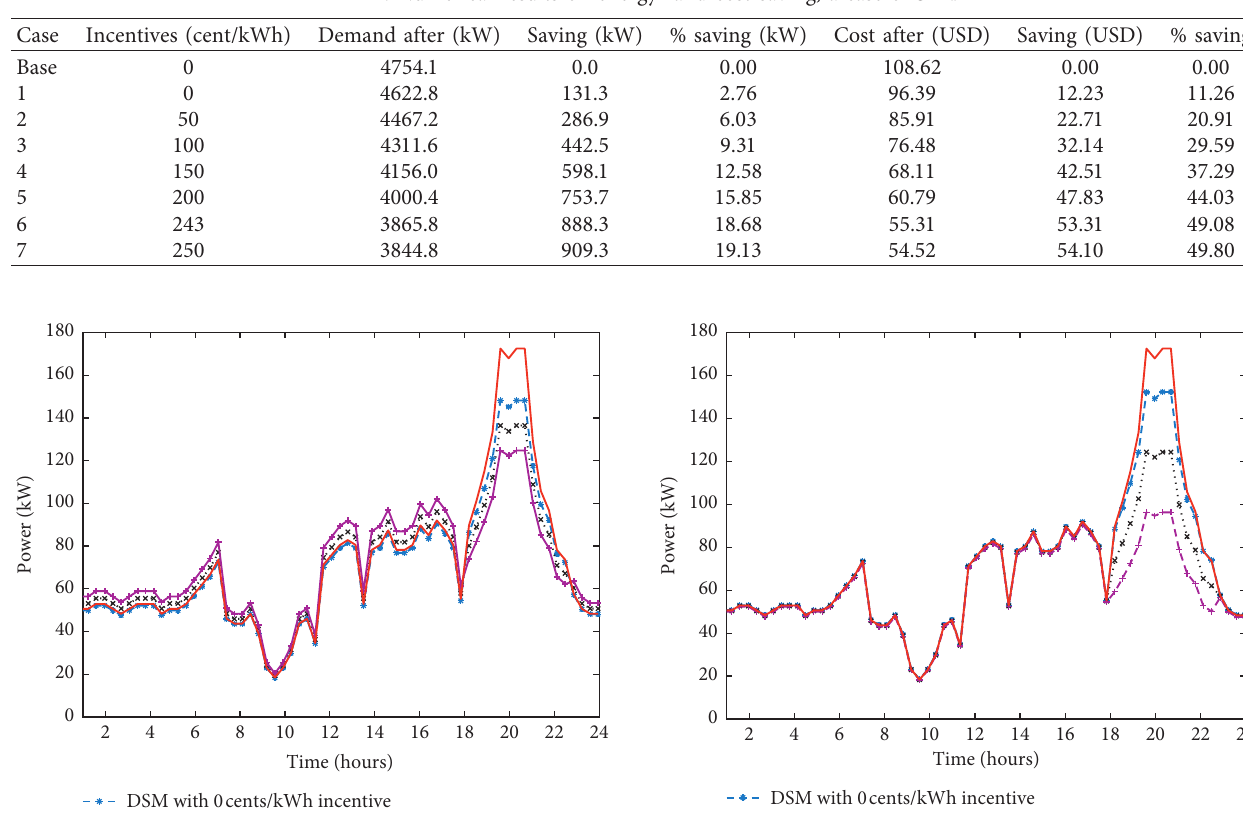
Table 4: Numerical results on energy- and cost-saving, a case of SLR.